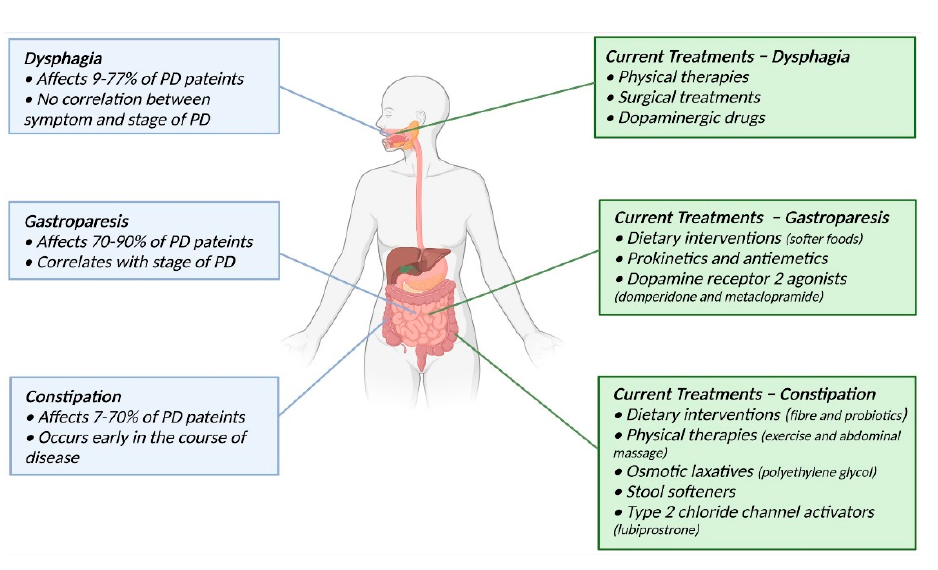
Figure 1. Common PD ‐ related GI dysfunctions and current